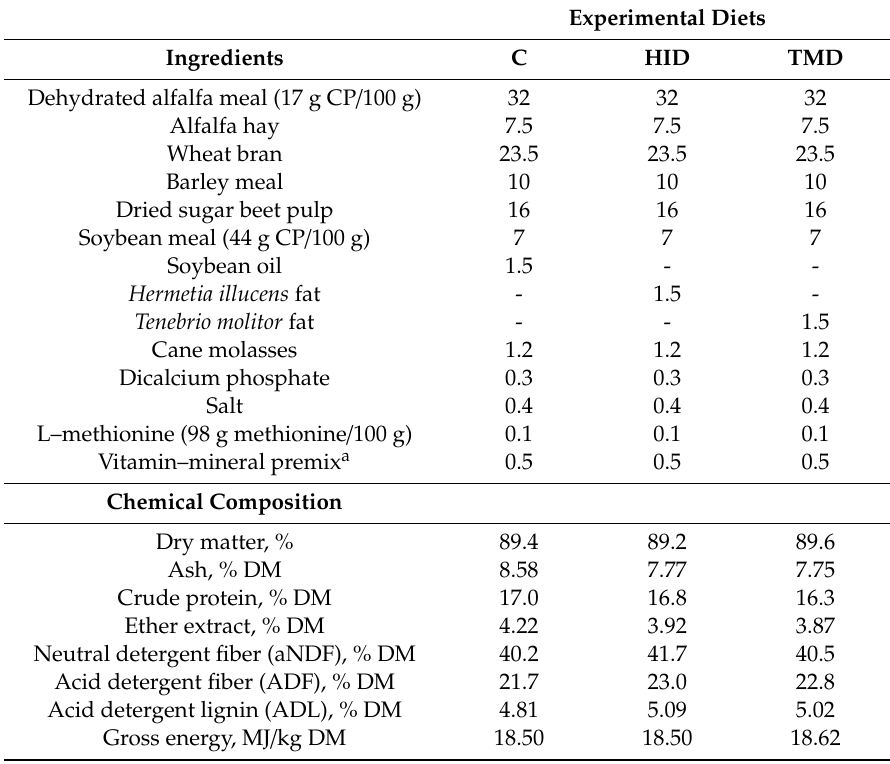
Table 1. Ingredients (% as fed) and chemical composition (% DM) of experimental diets. (modified from Gasco et al. [14]).